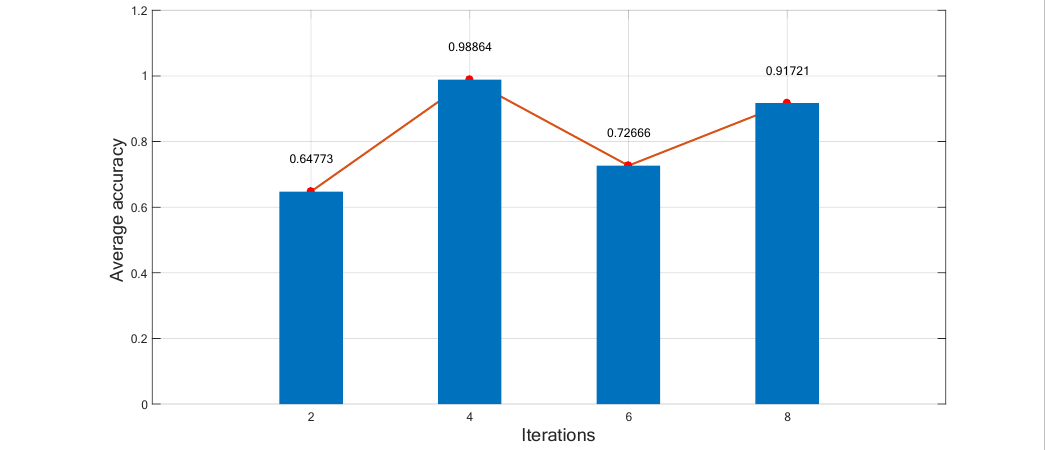
Figure 8. The average accuracy varies with the number of